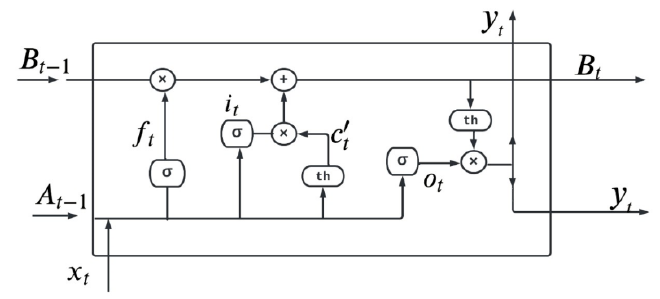
Figure 11. LSTM cell structure for breast adenocarcinoma.